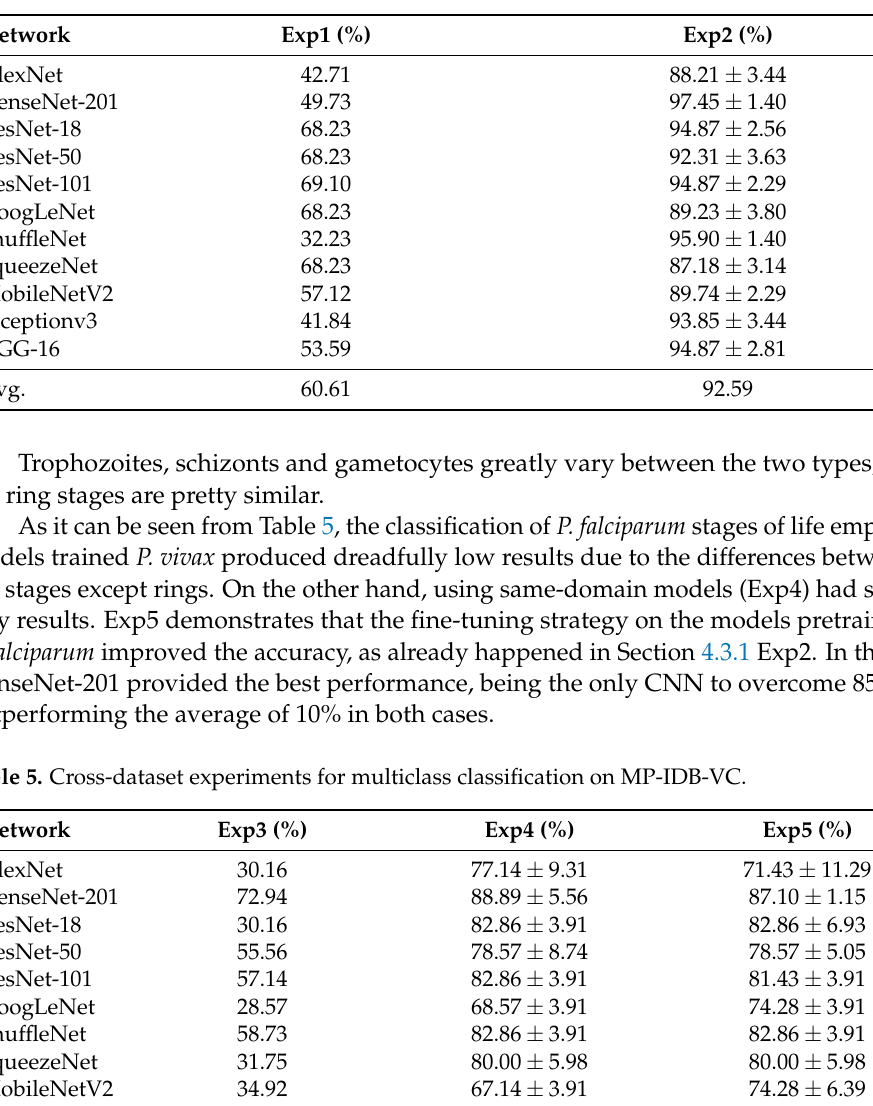
Table 4. Cross-dataset experiments for multiclass classification on MP-IDB-FC.